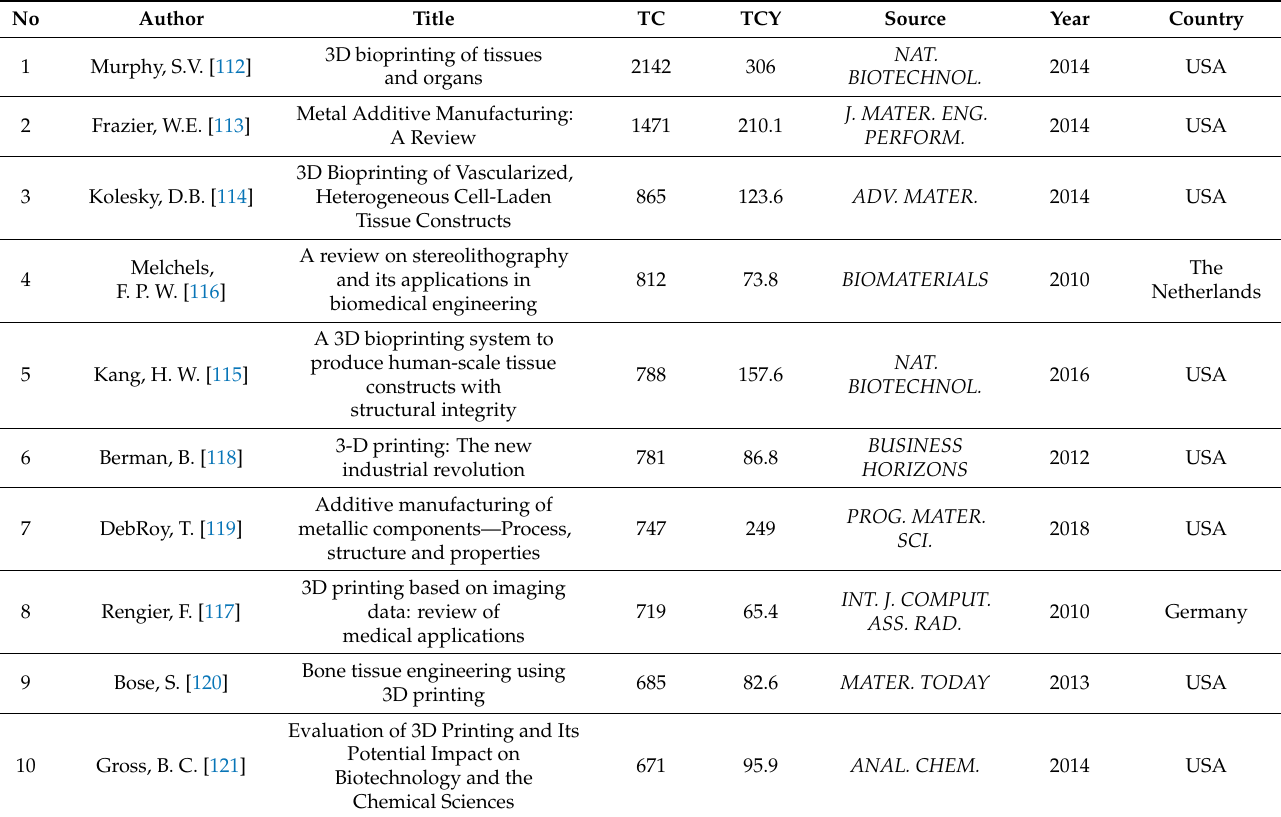
Table 6. Top 10 highly cited papers during the period of